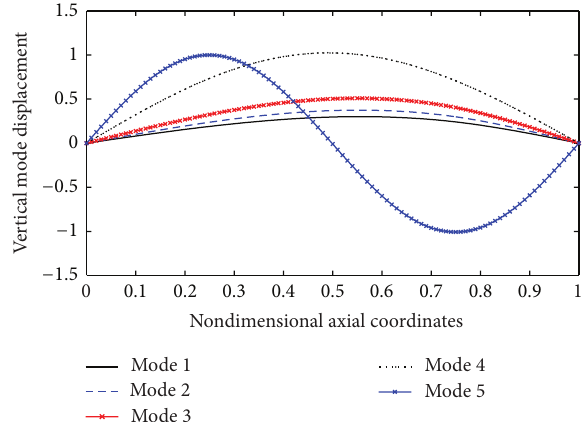
Figure 2: Mode shapes of a simply supported beam carrying three in-span spring-mass systems using the same parameters from [1].